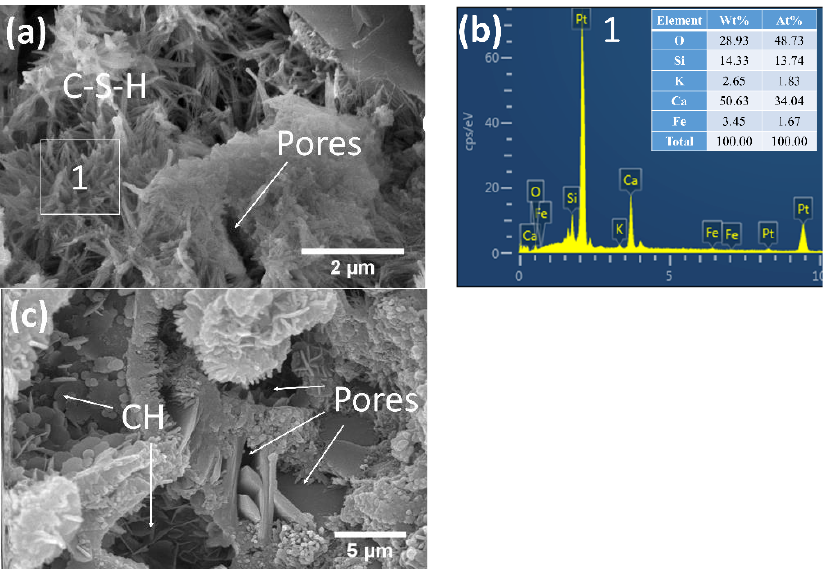
Figure 5. SEM images of pure cement paste after 80 °C steam curing for 7 h, ( a ) fibrous C-S-H gels; ( b ) EDS result of area 1; ( c ) pores. Note: Wt% represents the mass percentage, At% represents the atomic percentage.